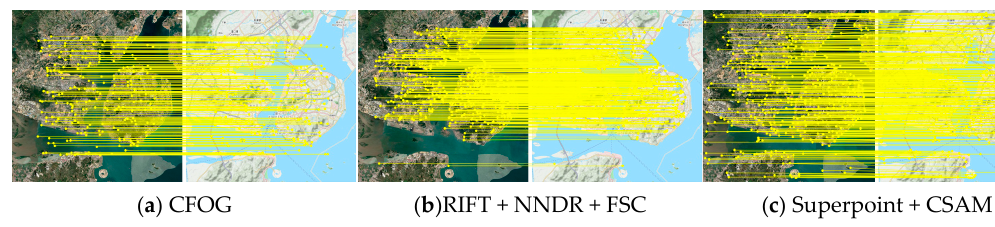
Figure 19. UAV Optical–infrared matching results.